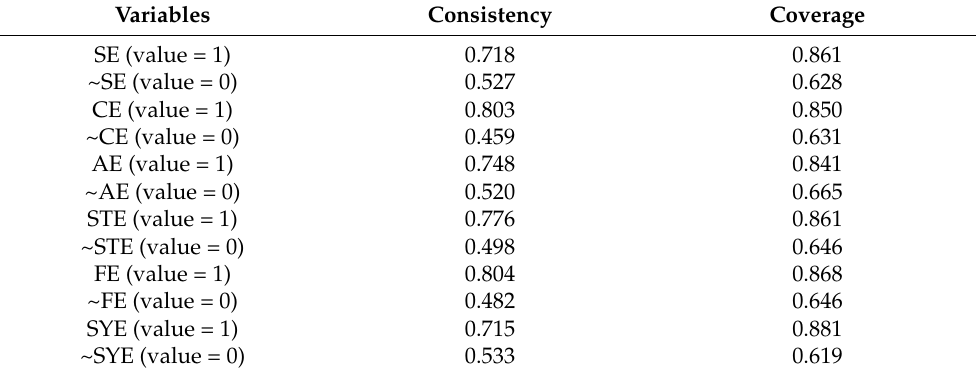
Table 5. Sufficient and Necessary Analysis of Antecedent Variables. Variables